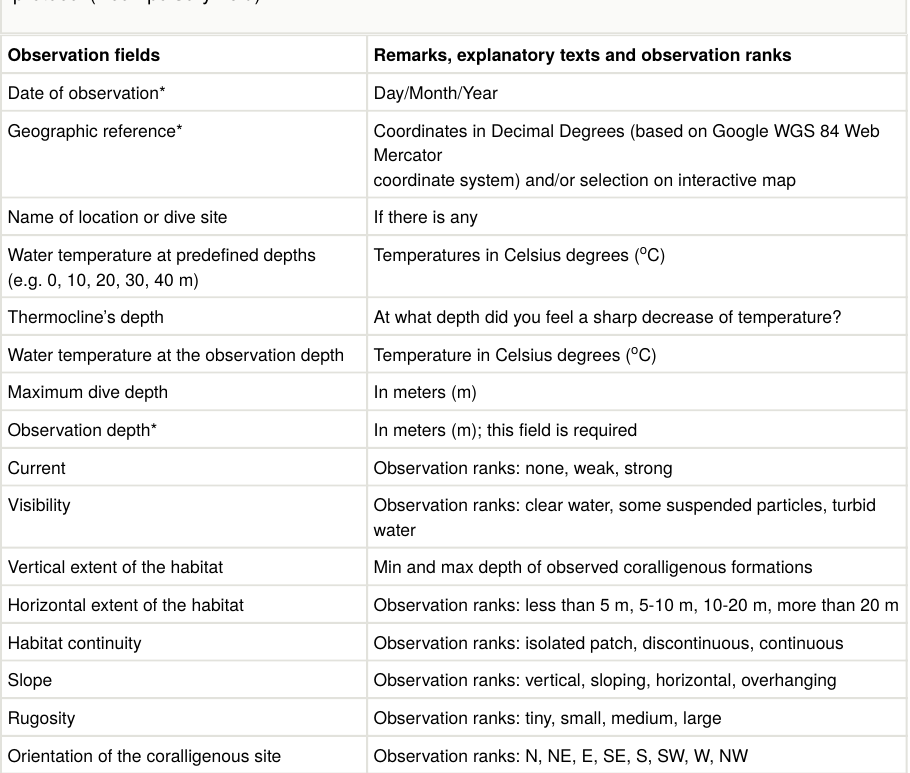
Table 1. Basic information requested in the data submission platform of the on the CIGESMED for divers protocol (* compulsory fi